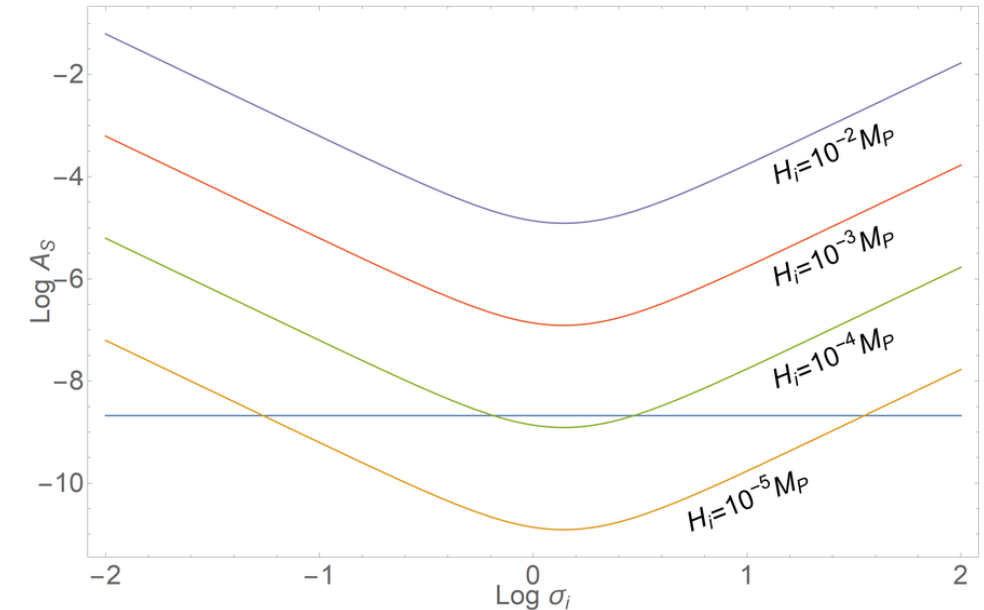
Figure 2. Amplitude of the spectrum of scalar perturbations predicted by the Pre-Big Bang scenario for different values of the bounce scale H i and the initial axion value in Planck units σ i